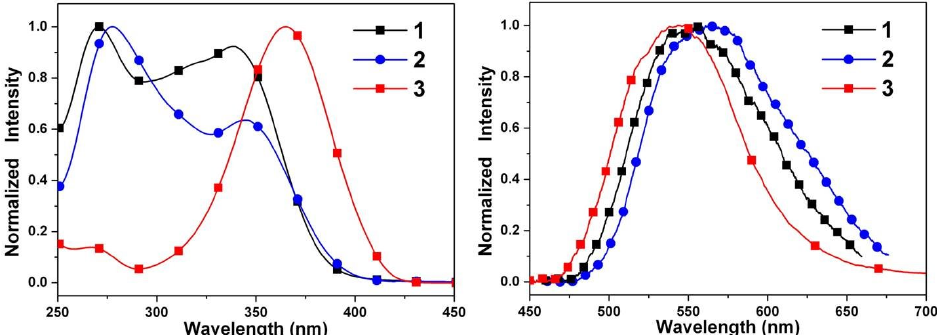
Figure 6. Normalized absorption ( left ) and emission ( right ) spectra of 1 – 3 in cyclohexane.